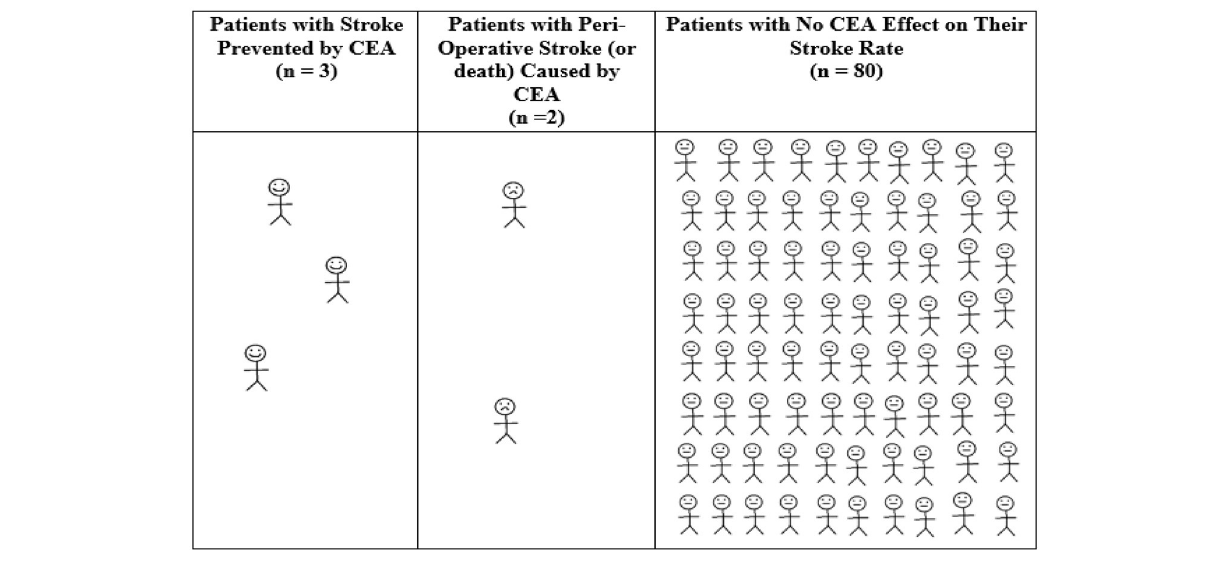
FIGURE 1 | Average 12-month outcomes for every 85 patients with asymptomatic carotid stenosis randomized to CEA in ACAS (35). Calculated from ACAS data regarding patients with 60–99% asymptomatic carotid stenosis (using “NASCET” criteria), the overall absolute annual ACAS stroke risk reduction from CEA and the 2.3% 30-day CEA rate of stroke or death in ACAS ( 35). There was a 5.9% reduction in any peri-operative stroke/death or later ipsilateral stroke in ACAS with CEA over 5 years using Kaplan Meier analysis (11.0% with medical intervention alone vs. 5.1% with CEA, or 1.18%/year risk reduction with CEA). Therefore, the number